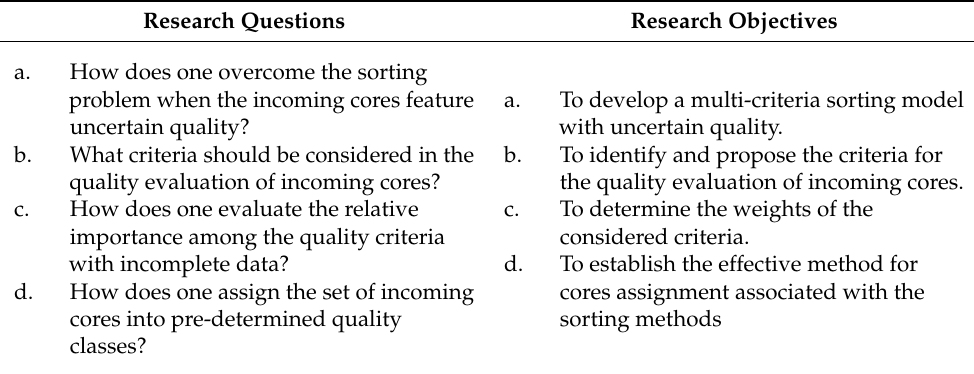
Table 1. Relevant research questions for research